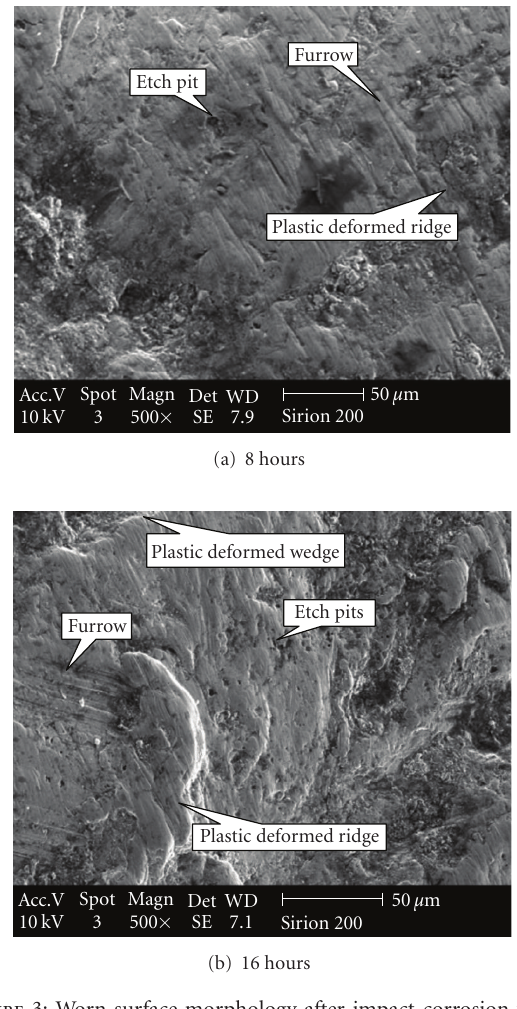
Figure 4: Worn surface morphology after impact-corrosion wear for 8 hours and 16 hours at the impact energy of